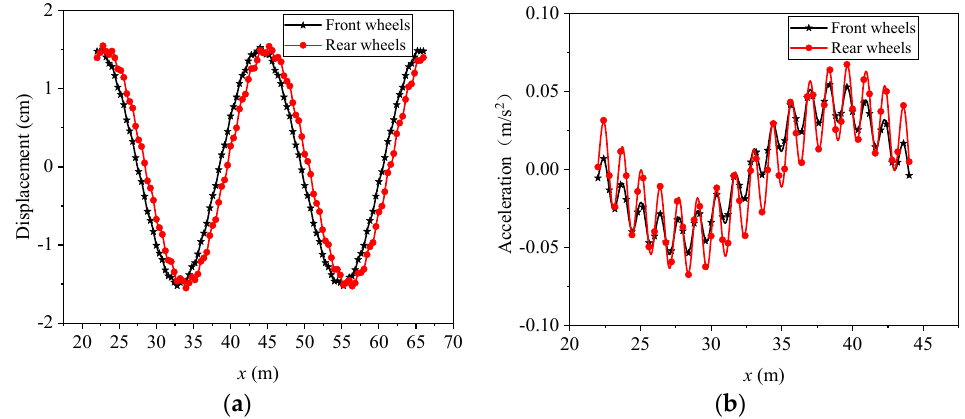
Figure 6. Net displacement ( a ) and vertical acceleration ( b ) of front and rear wheels ( b + c ) ≤ x ≤ 2 ns ( n ∈ N *).